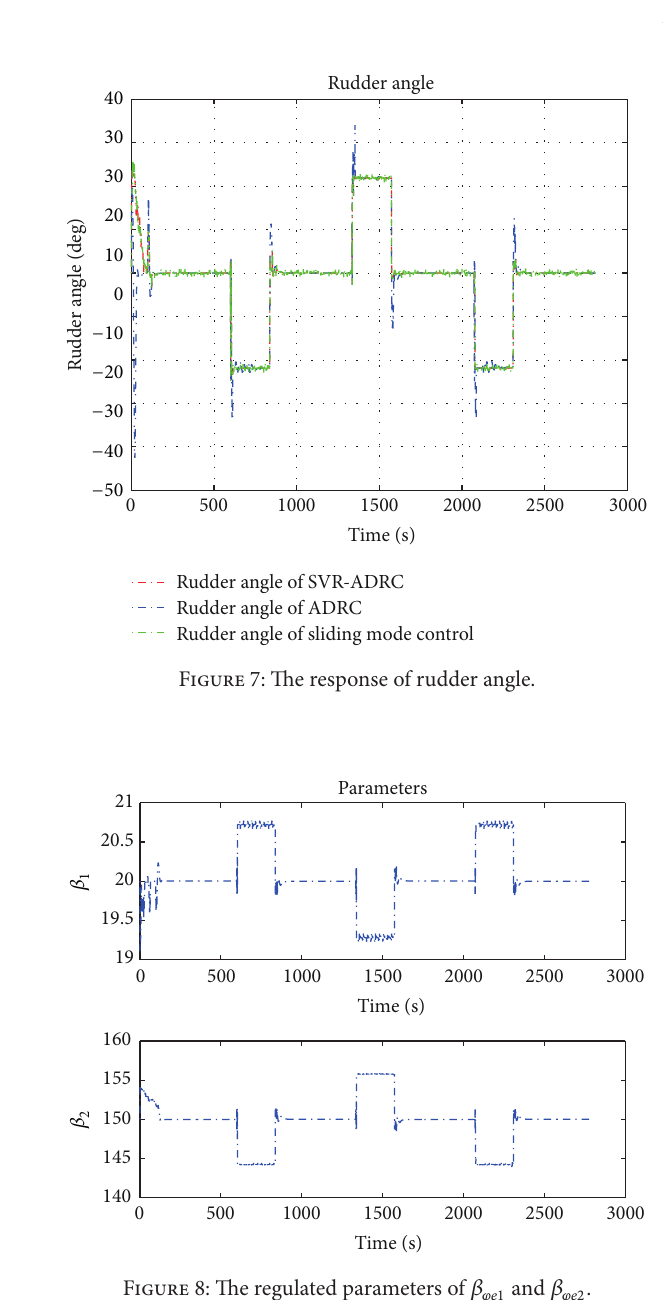
Figure 8: The regulated parameters of 𝛽 𝜑𝑒1 and 𝛽 𝜑𝑒2